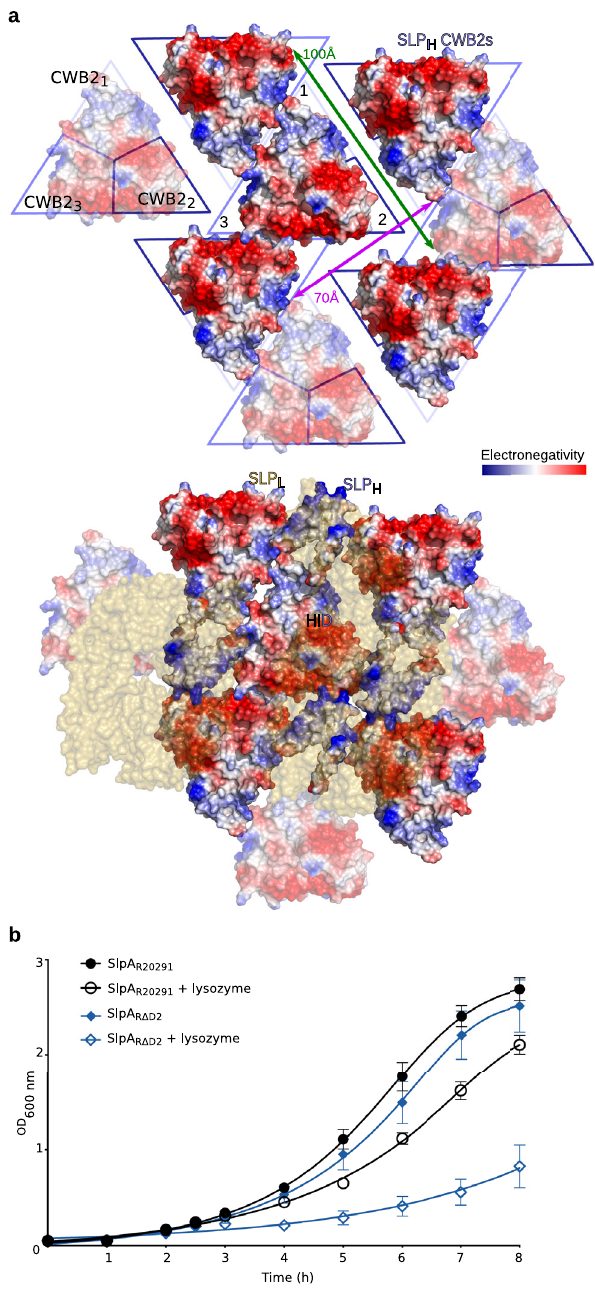
Fig. 6 SLP H and SLP L create a tightly packed 2D array. a Tiling of SLP H CWB2 motifs via charge complementarity across each triangular prism face. Poisson – Boltzmann electrostatic potential calculated for SlpA CD630 SLP H , represented as a charge distribution (positive – blue; negative - red) on the surface representation of SLP H array. Interacting surfaces between molecules 1 – 2, de fi ned by pseudo-symmetry related CWB2 3 -CWB2 1 , and between molecules 1 – 3, de fi ned by symmetry-related CWB2 3 triangular prism faces, are labelled. Cavity between symmetry-related CWB2 1 -CWB2 2 surfaces, represented by green arrows (top) is partially obstructed by HID domains (electrostatic potential surface representation) and completely occluded by SLP L (gold) as shown on the bottom panel. A long cavity of ~70 Å at the CWB2 2 vertices represented by purple arrow (top) is also occluded by HID domains and interacting SLP L molecules (bottom). b Lysozyme resistance. Cultures of SlpA R20291 (circles) and SlpA R Δ D2 (diamond) were inoculated at an OD 600nm of 0.05 and grown anaerobically at 37 °C with hourly OD 600nm measurements. Where indicated (open circles, SlpA R20291 ; open diamonds, SlpA R Δ D2 ) lysozyme (500 μ g ml − 1 ) was added after 2.5 h growth. Data are presented as mean values (±SD) from two biological replicates, assayed in triplicate. Source data provided